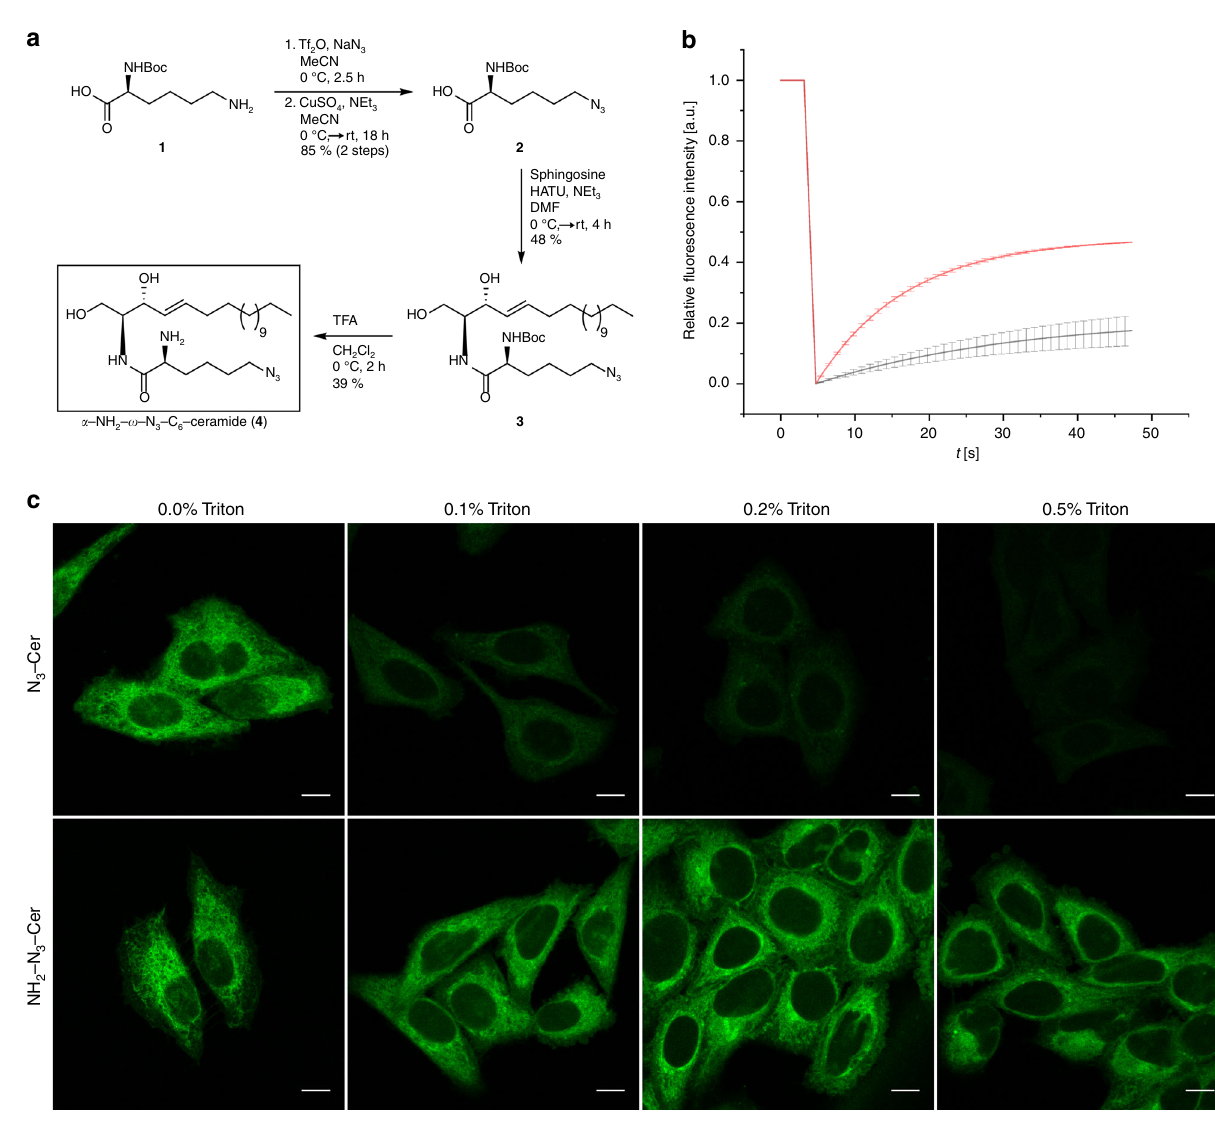
Fig. 1 Amino- and azido-functionalized sphingolipids enable fi xation and fl uorescence labeling of lipids. a Schematic overview of the synthesis of α -NH ω -N 2 - 3 -C 6 -ceramide (for synthesis details see Material and Methods and Supporting Information). To investigate the mobility of membrane- incorporated functional sphingolipids HeLa229 cells were fed with 10 µ M α -NH 2 - ω -N 3 -C 6 -ceramide or ω -N 3 -C 6 -Ceramide, fi xed, permeabilized and stained with DBCO-Alexa Fluor 488. b FRAP experiments with the two incorporated ceramide analogs. After three confocal fl uorescence imaging frames, a circular region of interest with a diameter 1.8 µ m was bleached and fl uorescence recovery followed over time. The α -NH 2 - ω -N 3 -C 6 -ceramide (black) shows a lower mobility (mean mobile fraction of 22.2%) than the ω -N 3 -C 6 -ceramide (red) lacking the primary amino group (mobile fraction of 48.1%). Source data are provided as Source Data fi le. c Confocal fl uorescence images of fi xed and labeled cells in the presence of increasing concentrations of the detergent Triton- X100. With increasing Triton-X100 concentration ω -N 3 -C 6 -ceramide (N 3 -Cer) is ef fi ciently washed out while the α -NH 2 - ω -N 3 -C 6 -ceramide (NH 2 -N 3 -Cer) signal remains preserved. The data were obtained from n = 2 independent experiments. Scale bars, 10 µ